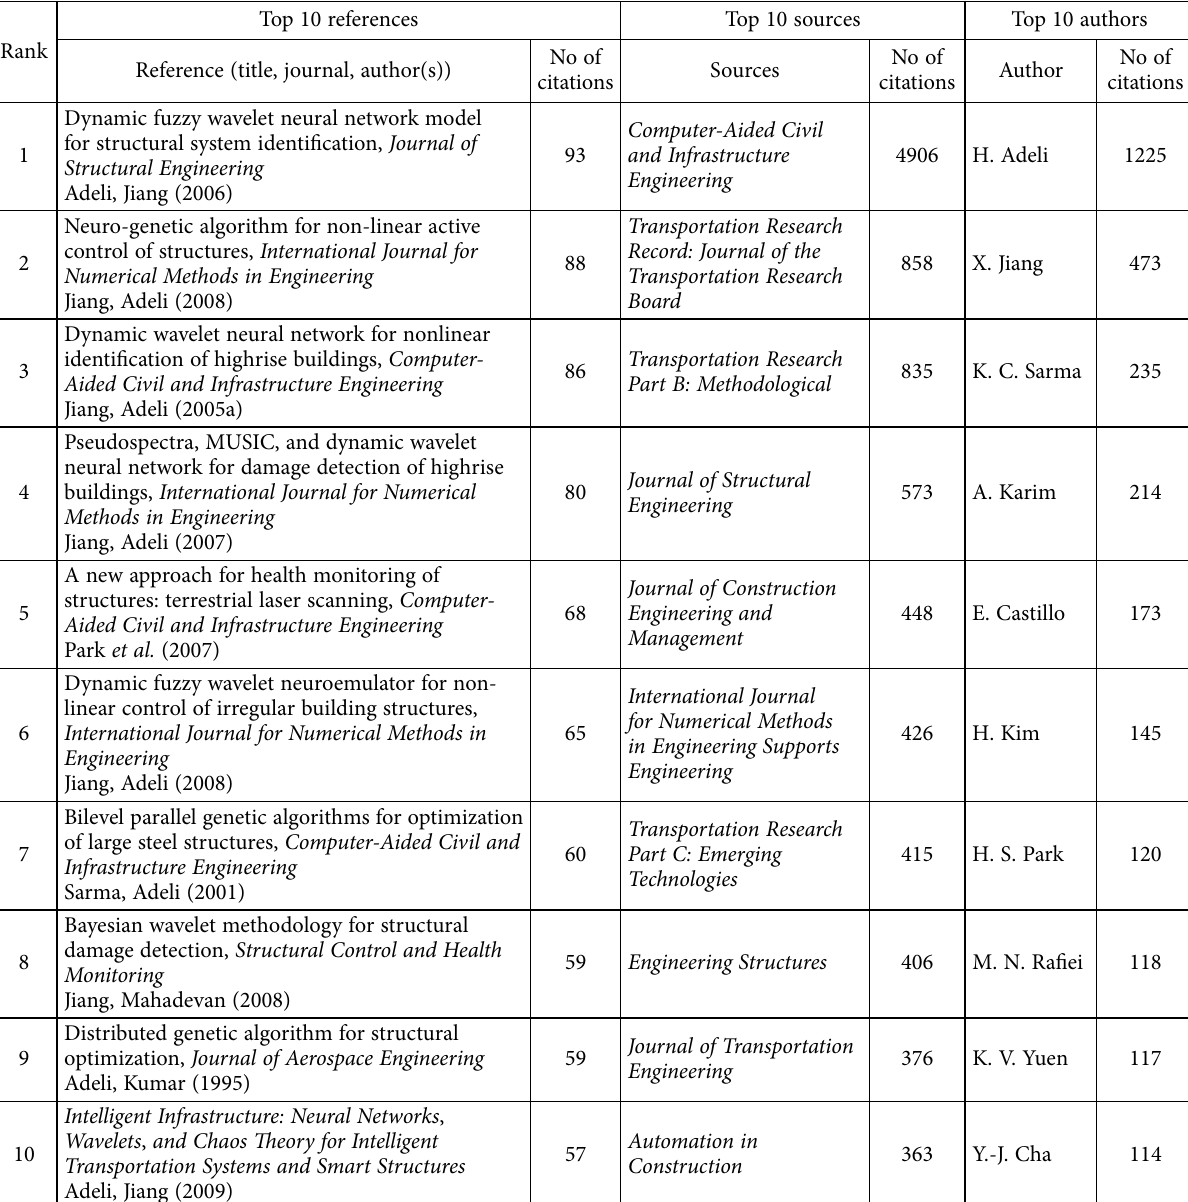
Table 2. Top 10 cited references/sources/authors of publications in the